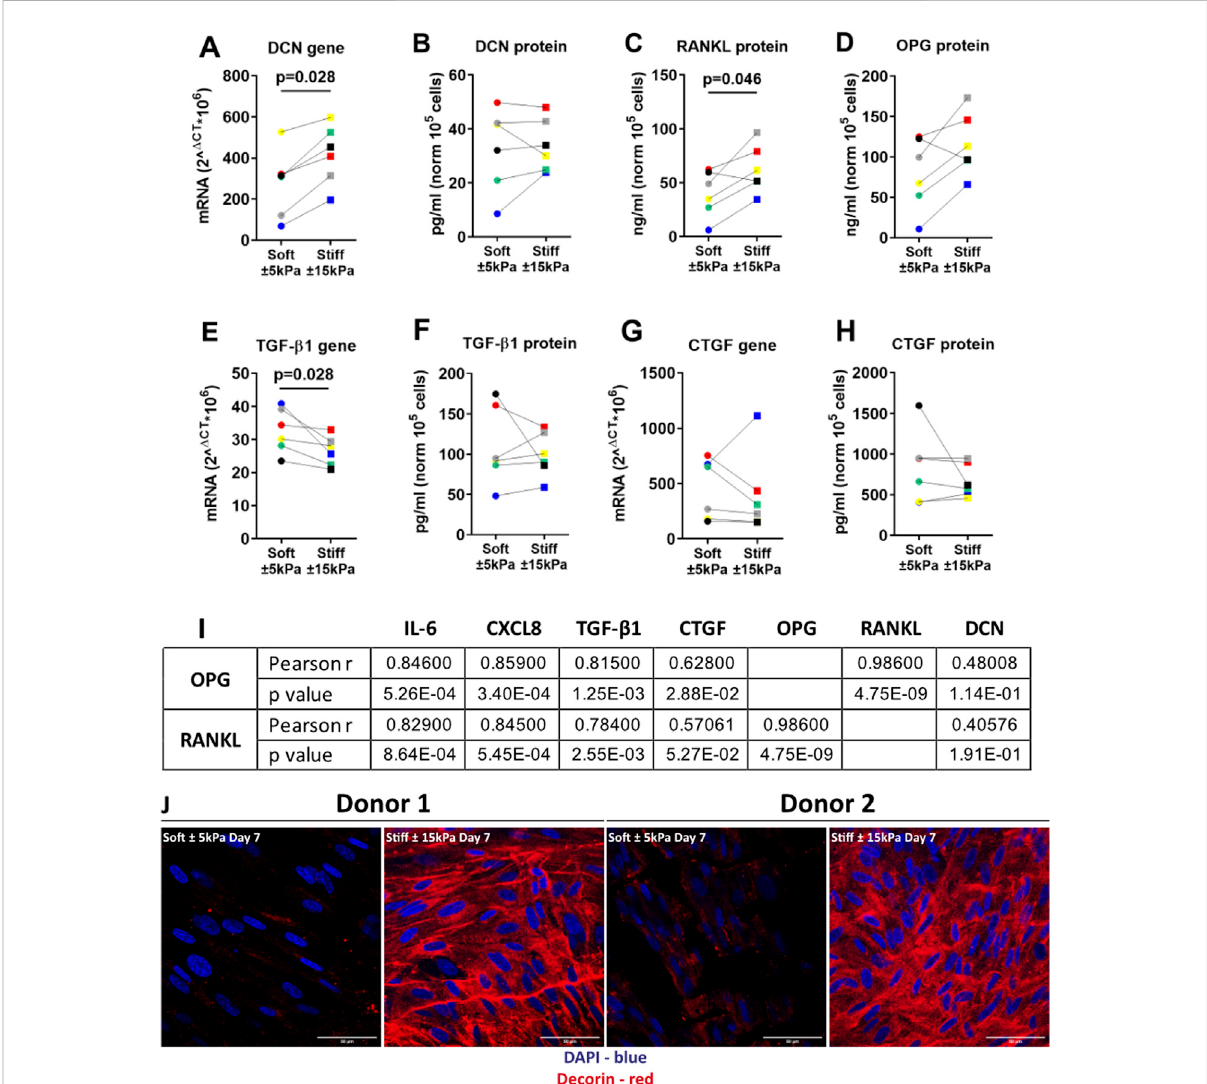
FIGURE 5 Stiffness induced a secretory phenotype in Primary human lung fi broblasts cultured on stiff matrices. (A,B) DCN gene expression and secreted proteinweremeasuredafter7 daysofcultureonsoft(3.94±0.87 kPa)andstiff(11.34±3.82 kPa)hydrogels. (C – H) LevelsofsecretedfactorsRANKL, OPG, CTGF and TGF- β 1 including TGF- β 1 and CTGF gene expression after 7 days of culture on soft and stiff hydrogels. I) Correlation was calculated between OPG, RANKL and all other secreted factors. Panel J shows a fl uorescent staining for DCN, DAPI was used for identi fi cation of cell nuclei. Illustrated photographs are representative images of in total 7 unique donors. Gene expression data were normalised against 18S and expressed as 2 − Δ CT x 10 6 . Secreted matrix proteins and cytokines were normalised to cell counts and expressed as pg/ml or ng/ml 10 5 cells. Differences between soft and stiff hydrogels were analysed by a Wilcoxon matched pairs signed rank test. Correlation was calculated using Pearson correlation coef fi cient. ( n = 6) Scale bar = 50 µm. Each donor has a different unique colour (blue, red, yellow, green, black, and